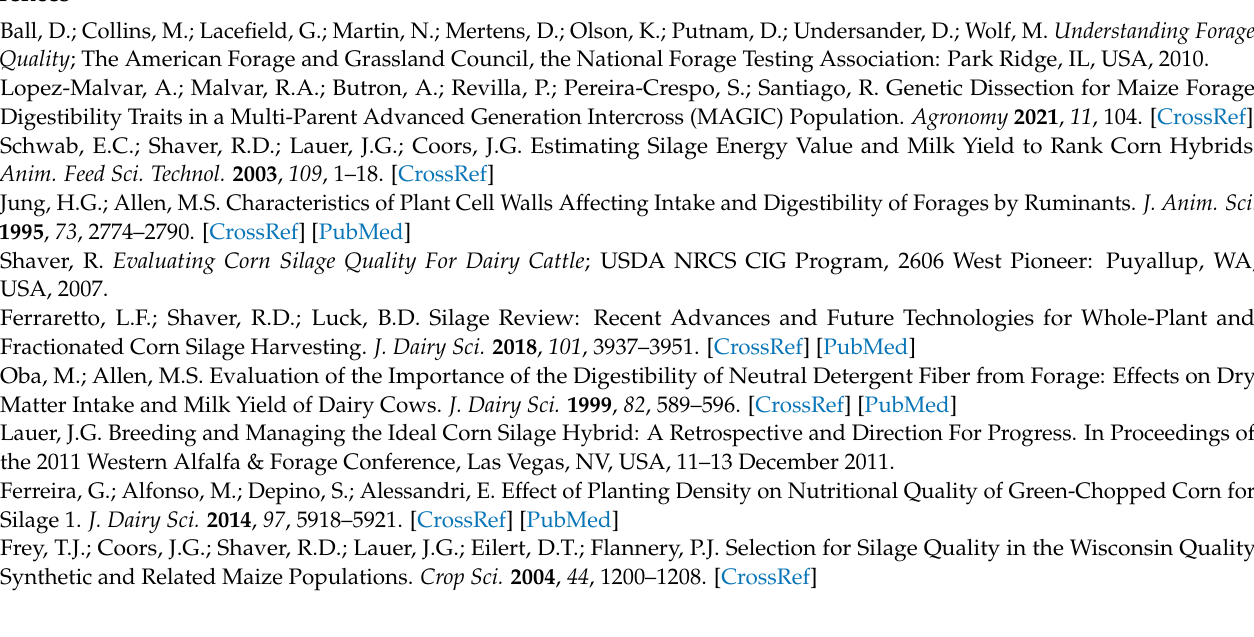
Figure S7: Heatmap of WAASB/Milk ha − 1 yield ratio scenarios; Figure S8: Heatmap of WAASB/Milk t − 1 yield ratio scenarios; Table S1: Industry standards; Table S2: List of location-year combinations with corresponding planting and harvest dates; Table S3: LRT test for all-random model of each tested trait; Table S4: Distribution of variance components per trait; Table S5: BLUP values of each trait; Table S6: AMMI significance table; Table S7: Environments ranked for Milk ha − 1 BLUP values; Table S8: The WAASB and WAASBY Milk ha − 1 values of genotypes with their rankings; Table S9: The WAASB and WAASBY Milk t − 1 values of genotypes with their rankings; Table S10: Differentials between the means of selected genotypes and the total population; Table S11: Differentials for stabil- ity (WAASB) and combined performance and stability (WAASBY) between the selected 15% of the genotypes and the total